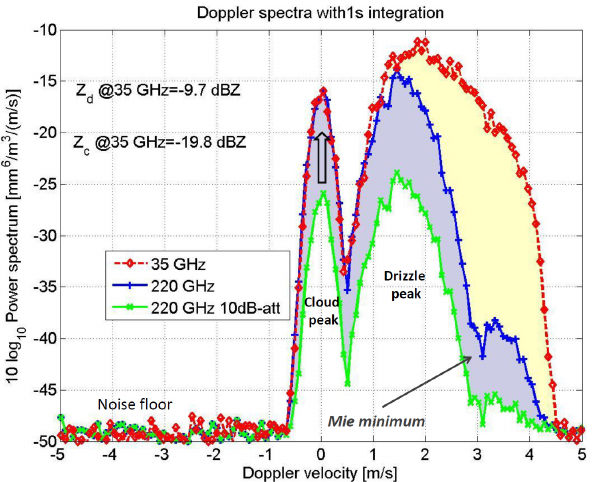
Figure 7. Example of 35 and 220GHz Doppler spectra simulated using a bimodal PSD with a cloud and a drizzle component. The single-pulse signal-to-noise ratio is assumed to be equal to − 25dBZ for both systems. The black arrow indicates the Rayleigh adjust- ment.